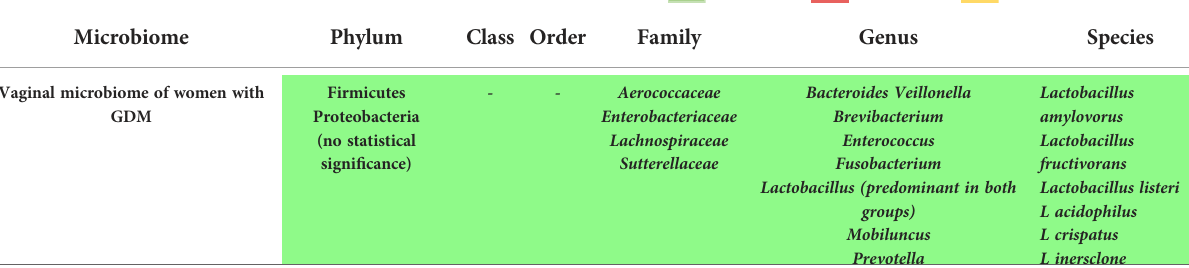
TABLE 5 Summary of the vaginal microbiome alterations in patients with GDM ( = Increased, = Decreased, =